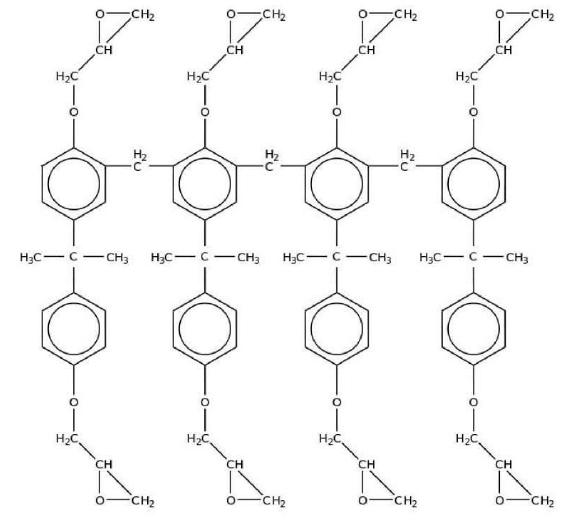
Figure 1. Chemical structure of a single SU-8 molecule.